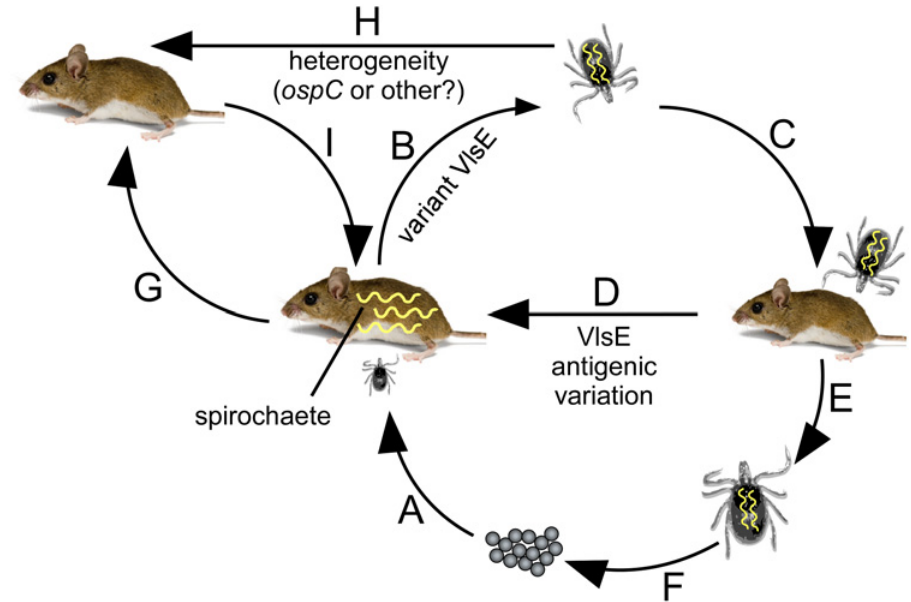
Fig 4. Summary of the importance of VlsE antigenic variation during the enzootic cycle of Borrelia burgdorferi . The stages (listed as A through I) of the life cycle of B . burgdorferi involving the tick vector and reservoir host are shown. A) Acquisition of spirochetes occurs when hatched tick larvae feed on infected Peromyscus mice during the summer months. B) The production of VlsE variants by spirochetes is necessary to escape anti- Borrelia antibodies present in the bloodmeal, allowing for efficient acquisition by larval ticks that are transstadially retained when the larvae molt into nymphs. C) Infected nymphal ticks transmit spirochetes while feeding on young, uninfected mice during the spring. D) Antigenic variation of VlsE by infecting B . burgdorferi in these young mice allows spirochetes to persist at least until the summer months in order to be acquired by tick larvae, thereby perpetuating the life cycle of the pathogen. E and F) Infected nymphs molt into adult ticks, which are not considered to be important for maintaining B . burgdorferi in nature. Adults typically feed and mate on large mammals such as deer, resulting in the next generation of tick vectors. G, H and I) Although not well studied, it is possible that immune clearance of spirochete infection occurs in certain numbers of mice. These mice may become reinfected by feeding nymphs that carry a strain of B . burgdorferi that is heterogeneous in some way to the original infecting strain. This capacity for reinfection might be highly advantageous for maintenance of the pathogen during ecological situations when immunologically na ï ve mammalian reservoir populations are of limited